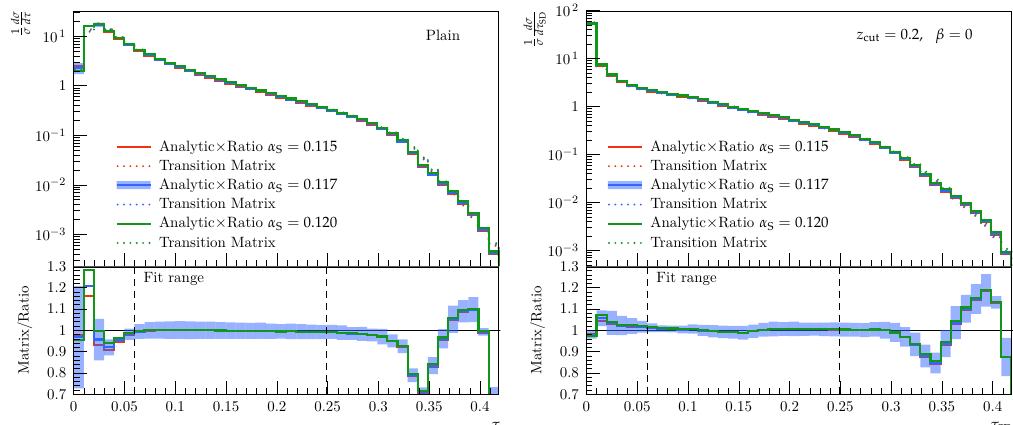
Figure 12. Comparison of di(cid:11)erent methods to apply hadronisation corrections obtained from Monte Carlo to the analytic calculations, for plain thrust (left) and soft-drop thrust (right) with z cut = 0 : 2 ; (cid:12) = 0. The corrections are obtained from simulations at parton shower accuracy and are applied either by multiplying the analytic calculation at various (cid:11) s values by the ratio from Monte Carlo, as described in the main text (solid) or alternatively by applying a bin-by-bin transition matrix obtained from the same Monte Carlo run (dotted). The cluster hadronisation model is used in all cases, the blue band indicates the uncertainty assigned to the calculation for (cid:11) s = 0 : 117 based on the di(cid:11)erence to using the Lund model. The bottom panel shows the ratio between the distributions using the two methods for equal values of (cid:11) s